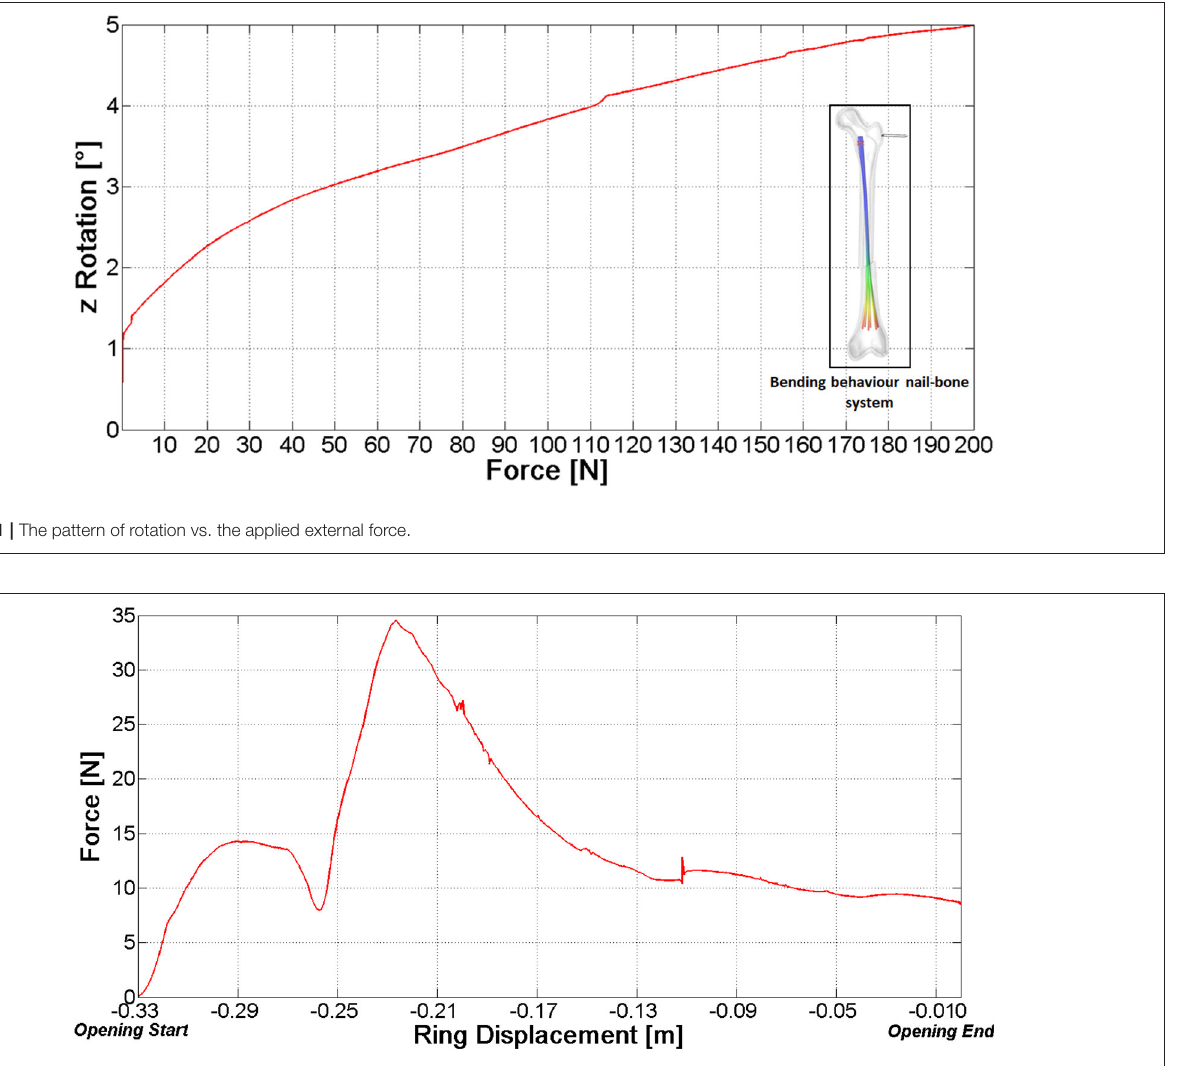
FIGURE 12 | Net force on the distal fragment vs. ring position (opening